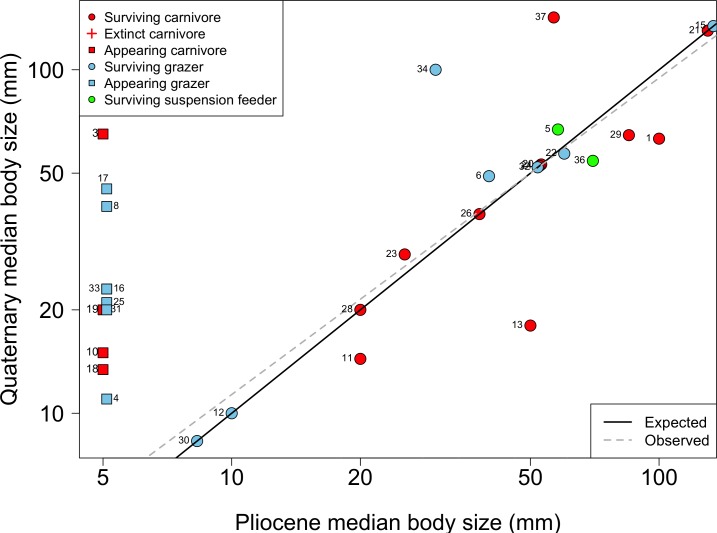
Changes in the median body size of 37 gastropod families across the Pliocene-Quaternary.Families were classified according to their feeding type and diversification dynamic. The solid line represents the null expectation of no change in median body size. The dotted line shows the fit of an OLS regression (r2 = 0.86, P < 0.001), where the slope (b = 1.15) was not different than the null expectation (P > 0.05). Also shown the median body size of families that went extinct or appeared. Families are depicted by numbers: 1 Buccinidae; 2 Bullidae; 3 Bursidae; 4 Calliostomatidae; 5 Calyptraeidae; 6 Cancellariidae; 7 Cassidae; 8 Cerithiidae; 9 Cliidae; 10 Columbellidae; 11 Drilliidae; 12 Ellobiidae; 13 Epitoniidae; 14 Fasciolariidae; 15 Fissurellidae; 16 Littorinidae; 17 Lottiidae; 18 Mangeliidae; 19 Marginellidae; 20 Mitridae; 21 Muricidae; 22 Nacellidae; 23 Nassariidae; 24 Naticidae; 25 Newtoniellidae; 26 Olividae; 27 Pseudolividae; 28 Pseudomelatomidae; 29 Ranellidae; 30 Rissoinidae; 31 Siphonariidae; 32 Tegulidae; 33 Trochidae; 34 Turbinidae; 35 Turridae; 36 Turritellidae; 37 Volutidae.